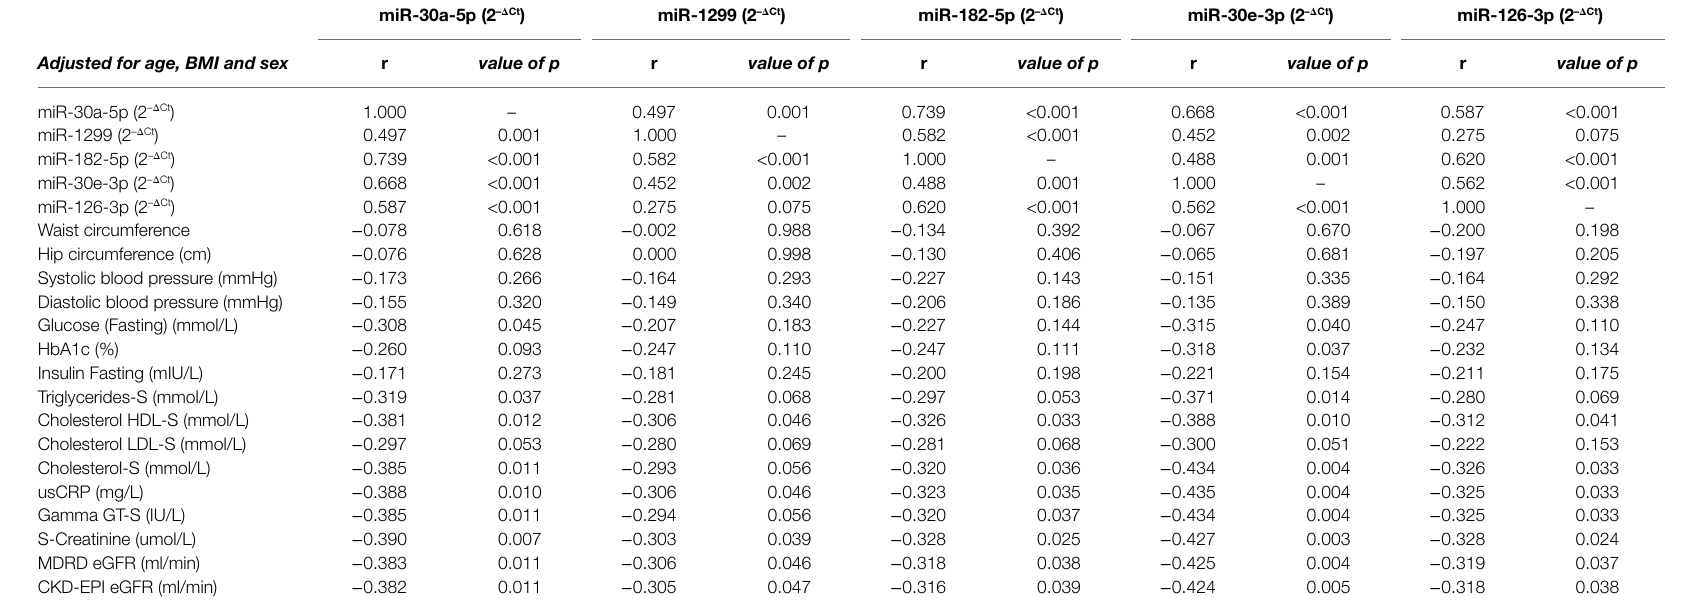
TABLE 3 | Partial Spearman’s correlation coefficients adjusted for age, sex and body mass index